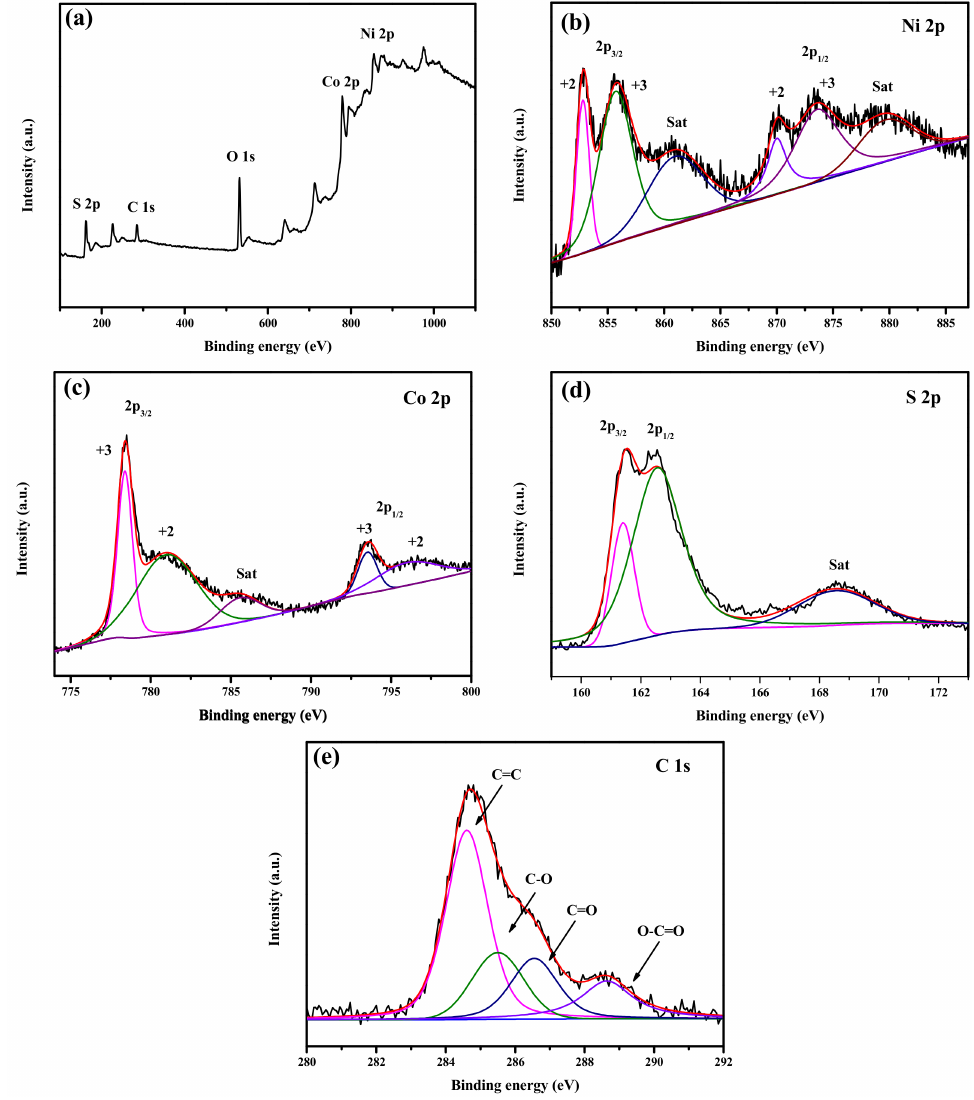
Figure 7. ( a ) XPS spectrum; ( b ) Ni 2p XPS; ( c ) Co 2p XPS; ( d ) S 2p XPS; ( e ) C 1s XPS of NiCo 2 S 4 / rGO